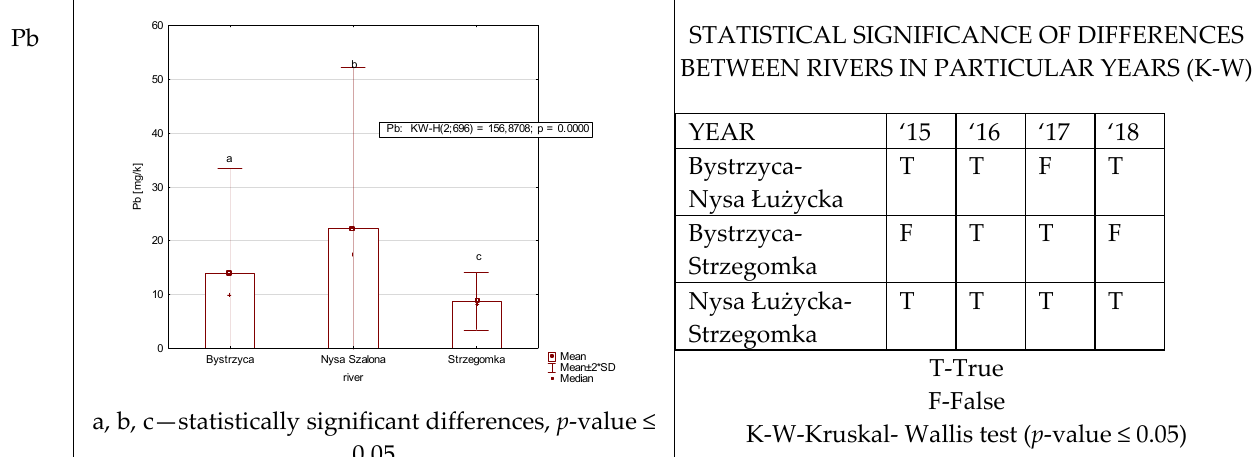
Figure 5. Pb concentration in plants from rivers across 29 sites depending on river (graph to the ( left )) and by year 2015–2018 in the table to the ( right ). Statistically significant differences are marked in the graph with letters a, b and in the table these differences are shown by year between rivers—T—differences were present, F—no statistical difference ( p -value ≤ 0.05).